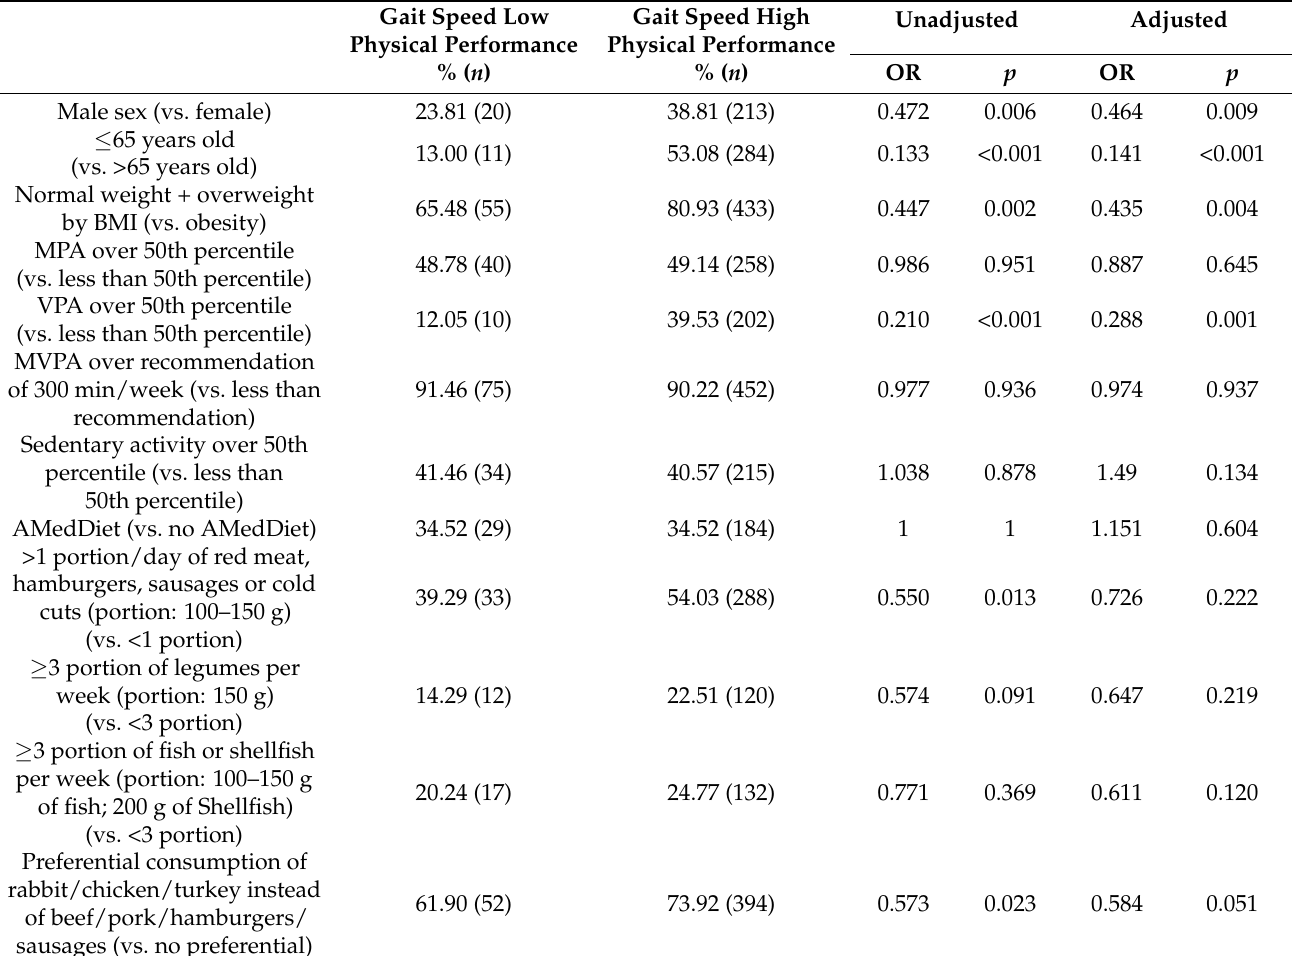
Table 6. Odds ratio of physical performance by gait speed unadjusted and adjusted by sex and